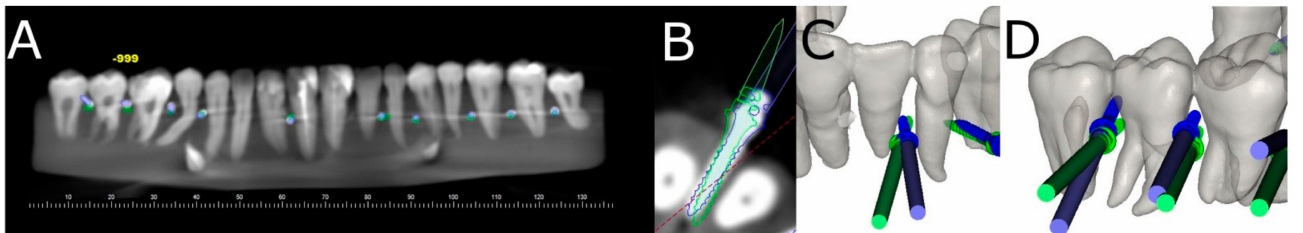
Figure 4. ( A ) Radiographic analysis of the root perforation in the 3D implant planning software, ( B ) Relationship between the root processes and the planned (green micro-screw) and performed (blue micro-screw) orthodontic micro-screws using a computer-aided static navigation technique ( C ) by the conventional free-hand technique and ( D ) mixed reality